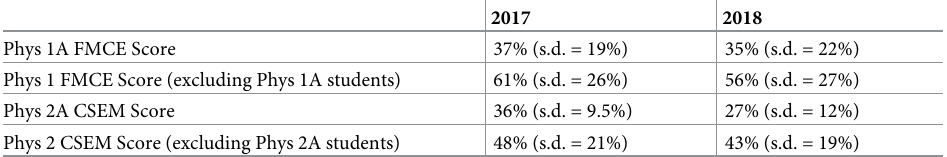
Table 5. Mean and standard deviation of FMCE scores for Phys 1 and Phys 1A, and CSEM pre-scores for Phys 2 and Phys